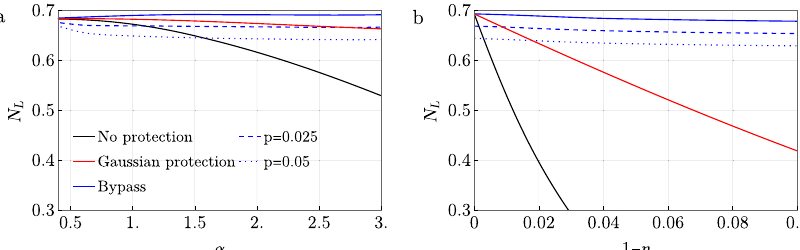
Fig. 4 Protection of entangled coherent states ECS (cid:1) j i in Fig. 1c quanti fi ed by numerically calculated logarithmic negativities. a vs. α for 1 − η = 0.01 and b vs. 1 − η for α =